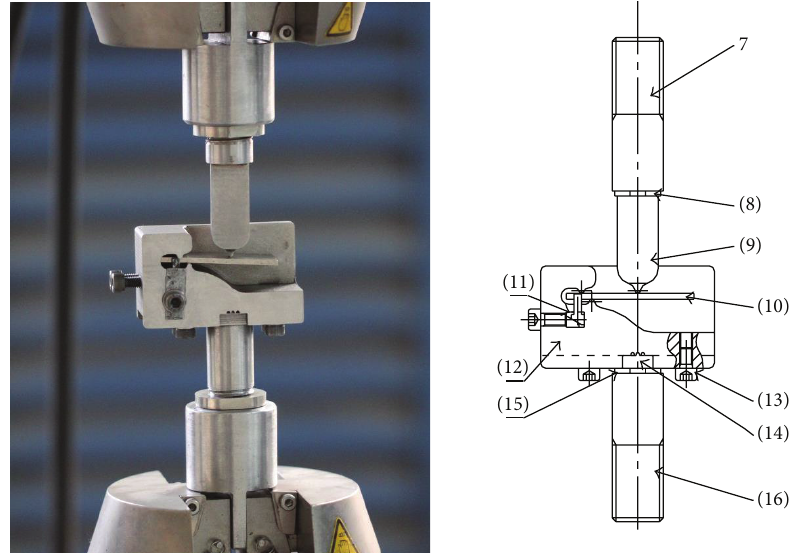
Figure 3: Schematic diagram of the test device.